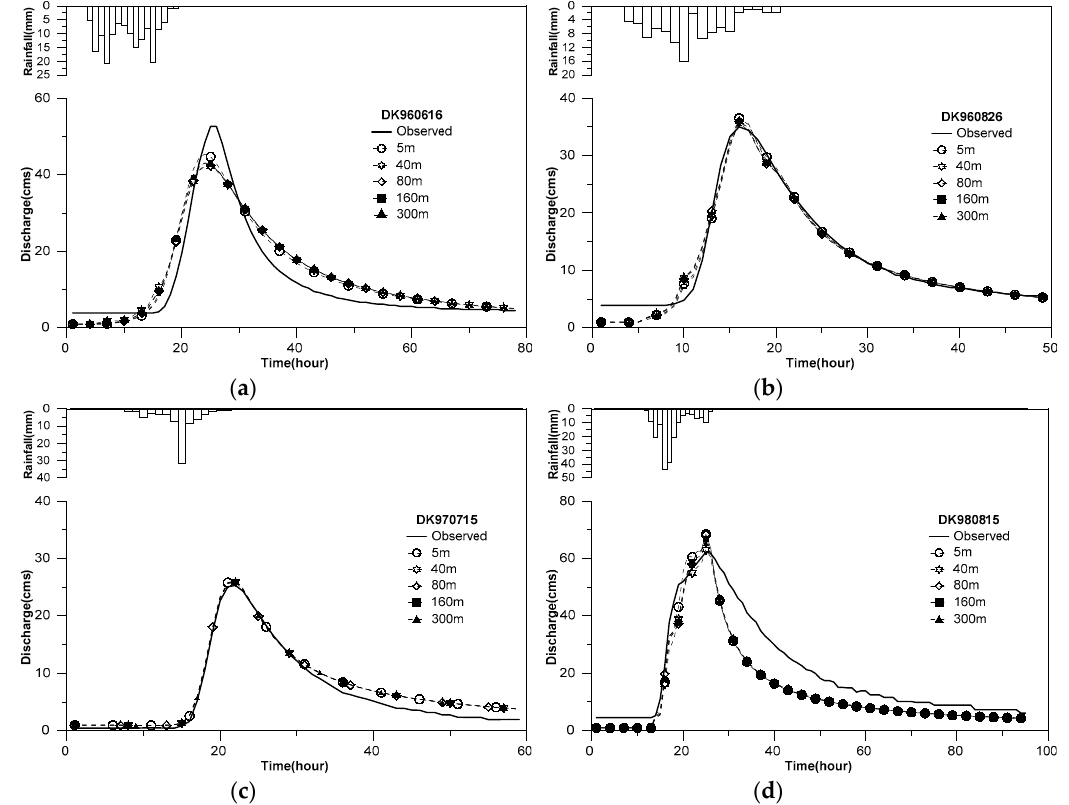
Figure 12. Rainfall–runoff events by applying optimized parameters in the Dongkok watershed depending on each DEM resolution. ( a ) 16 June 1996. ( b ) 8 August 1996. ( c ) 15 July 1997. ( d ) 15 August 1998.